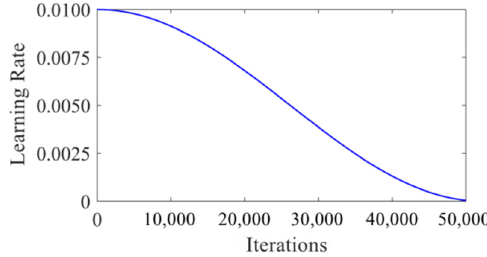
Figure 6. Attenuation curve of the cosine function.